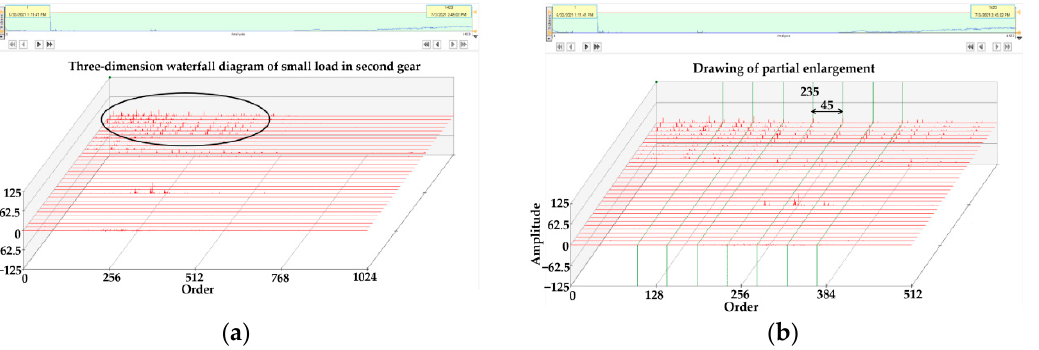
Figure 14. Three-dimension waterfall diagram ( a ) and drawing of partial enlargement ( b ) of difference spectrum of small load in second